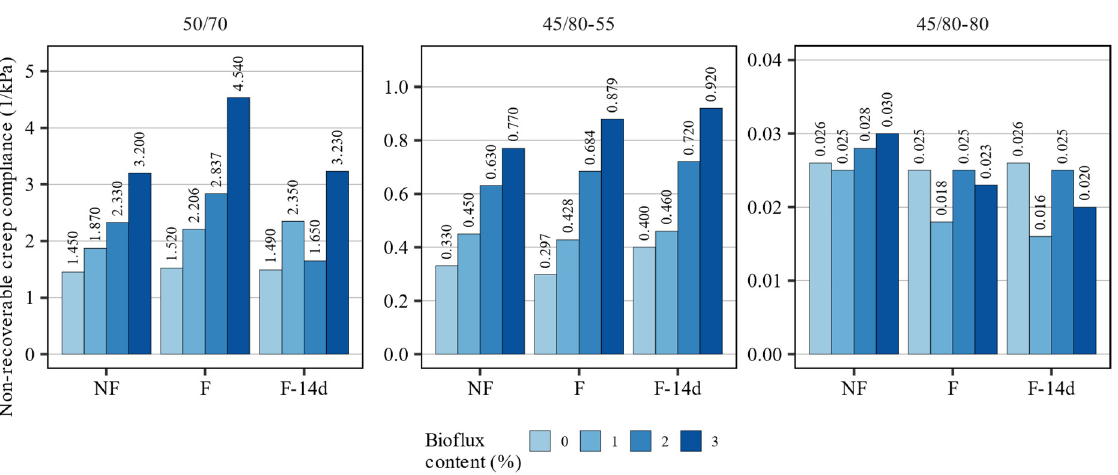
Figure 8. Non-recoverable creep compliance of the investigated binders measured at 3.2 kPa stress level and 60 °C.